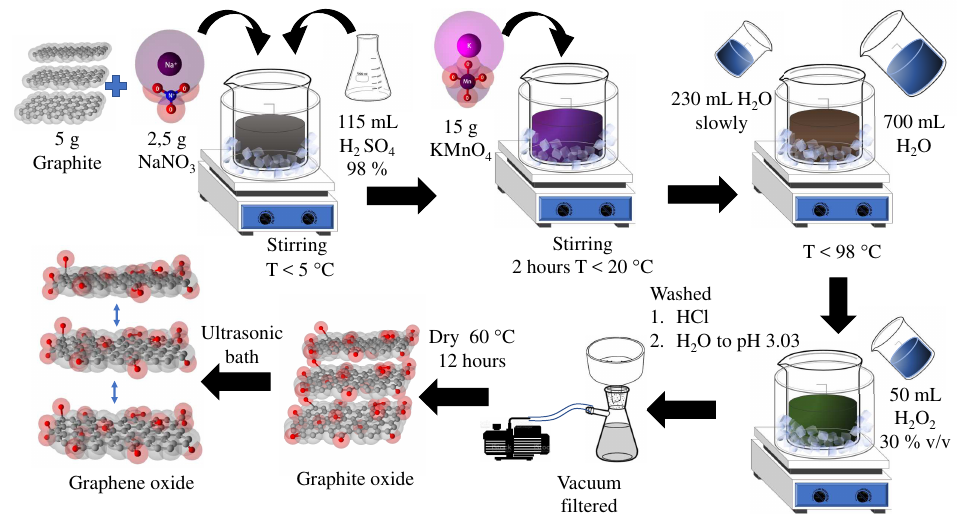
Figure 1. Synthesis of graphene oxide according to Hummer’s method